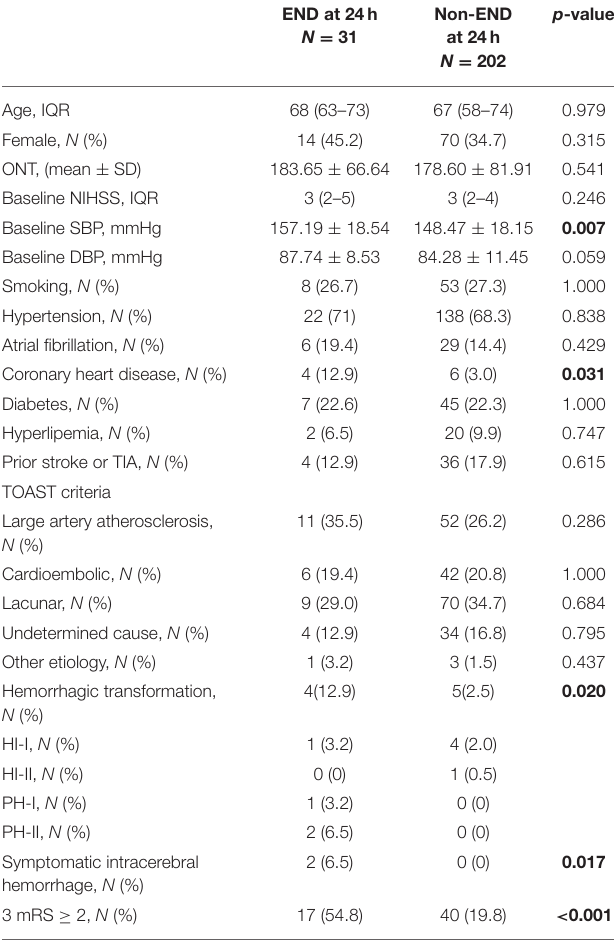
TABLE 1 | Characteristics of mild acute ischemic stroke patients with IVT with or without END at 24 h.